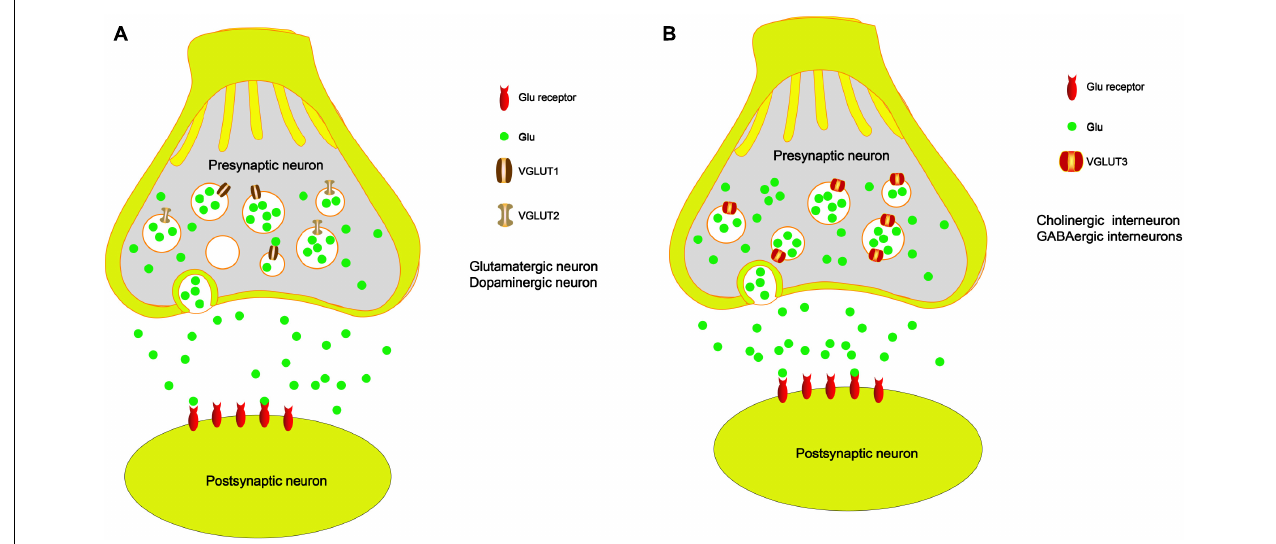
FIGURE 2 | The role of VGLUTs in the PD model. (A) VGLUT1 and VGLUT2 load Glu into vesicles, and they fuse with the presynaptic membrane and release Glu into the synaptic cleft, especially in the glutamatergic neurons and dopaminergic neurons. (B) VGLUT3 loads Glu into vesicles, and it fuses with the presynaptic membrane and releases Glu into the synaptic cleft, especially in the cholinergic neurons and GABAergic